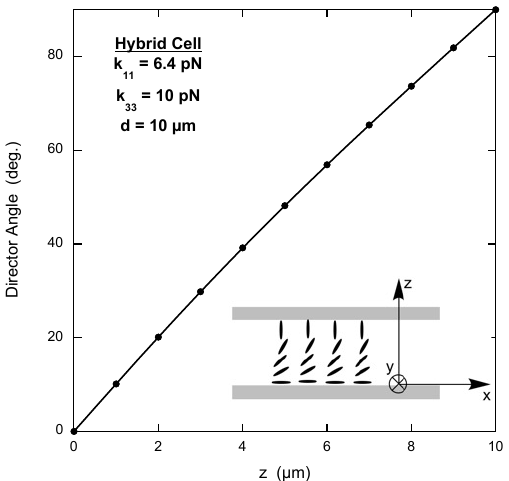
Figure 1. Director angle in a hybrid cell with infinite anchoring strength. Inset: schematic of a hybrid cell. The director angle is measured from the x -axis. Solid circles: genetic algorithm results. Solid line: exact